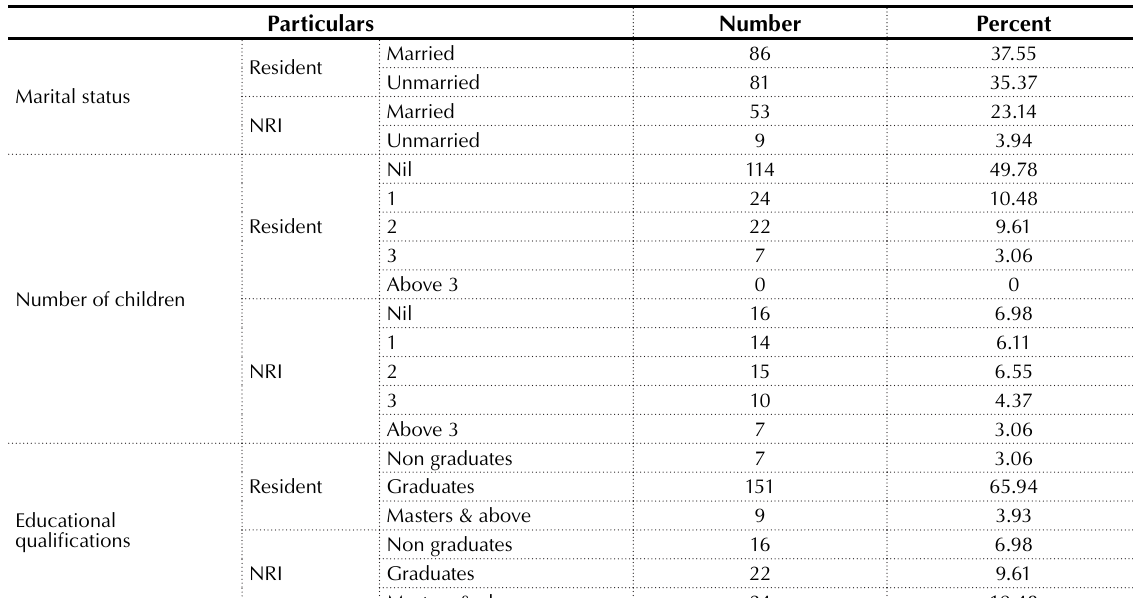
Table 1. Demographic particulars